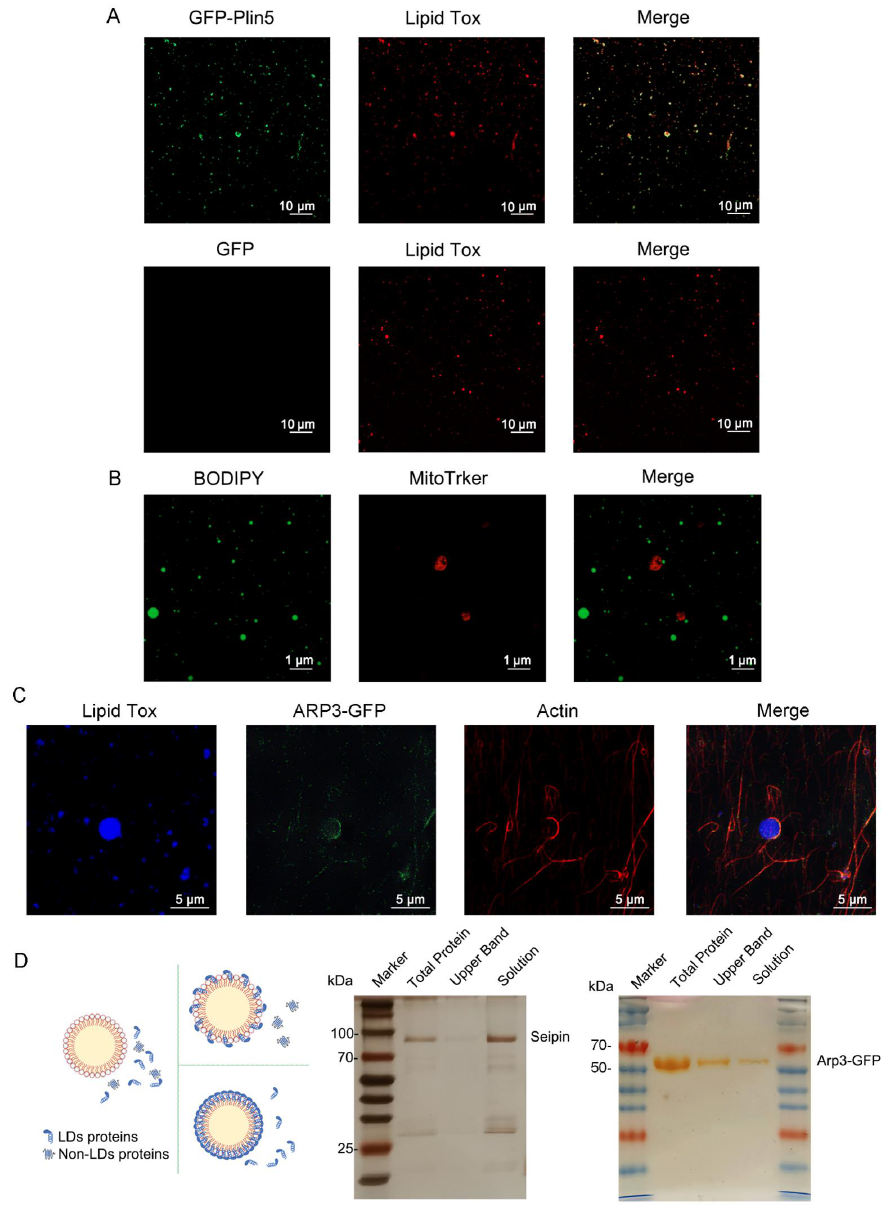
Figure 3. Organelles and specific protein recruitment of NLPs. ( A ) Plin5-GFP fusion proteins 2